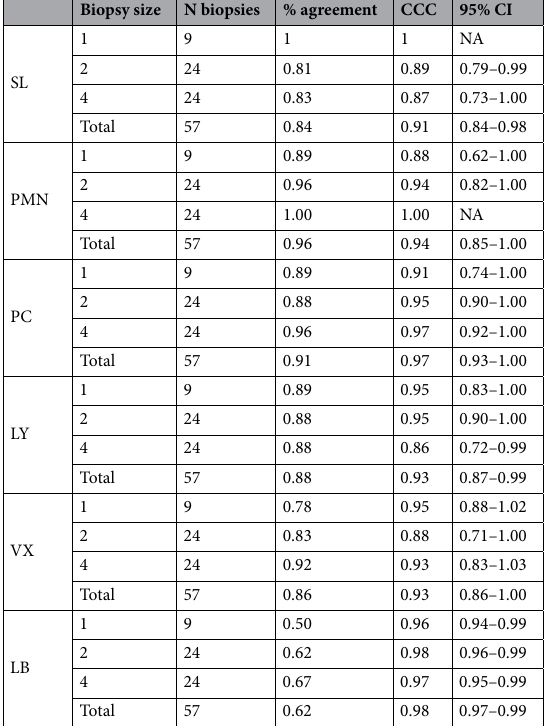
Table 3. Subscales and total De Bois-Tak scoring system inter-rater agreement and according to size of biopsy forceps. SL = lining layers ; PMN = Polymorphonuclear cells ; PC = plasma cells ; LY = lymphocytes ; VX = vessels ; LB = total de Bois-Tak ; NA = not available.